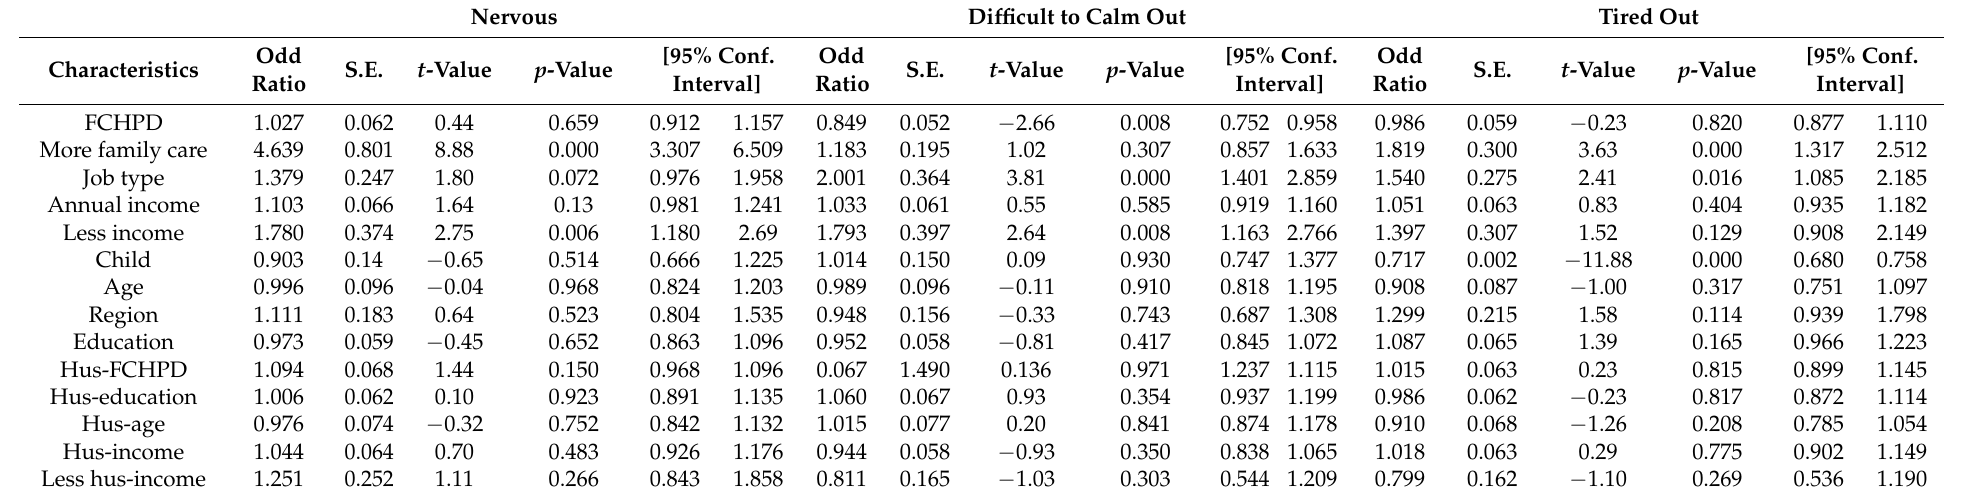
Table 2. Ordinal logistic regression of negative affects partially with different factors in the total